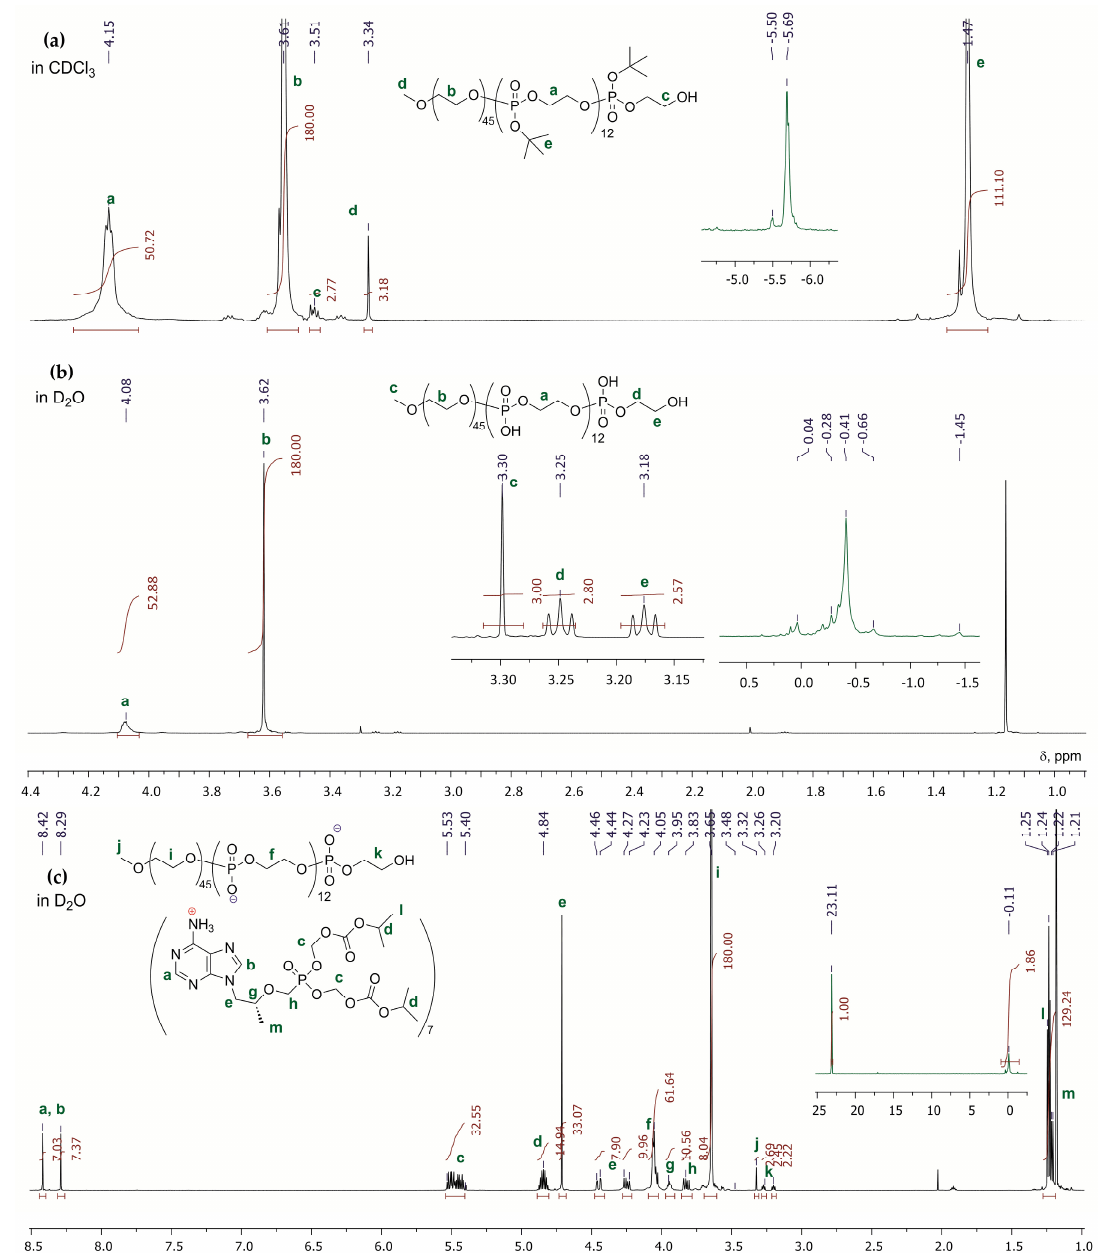
Figure 1. 1 H (black) and 31 P (green) NMR spectra of P1 ( a ), P3 ( b ) and 2P3-TFD ( c ).